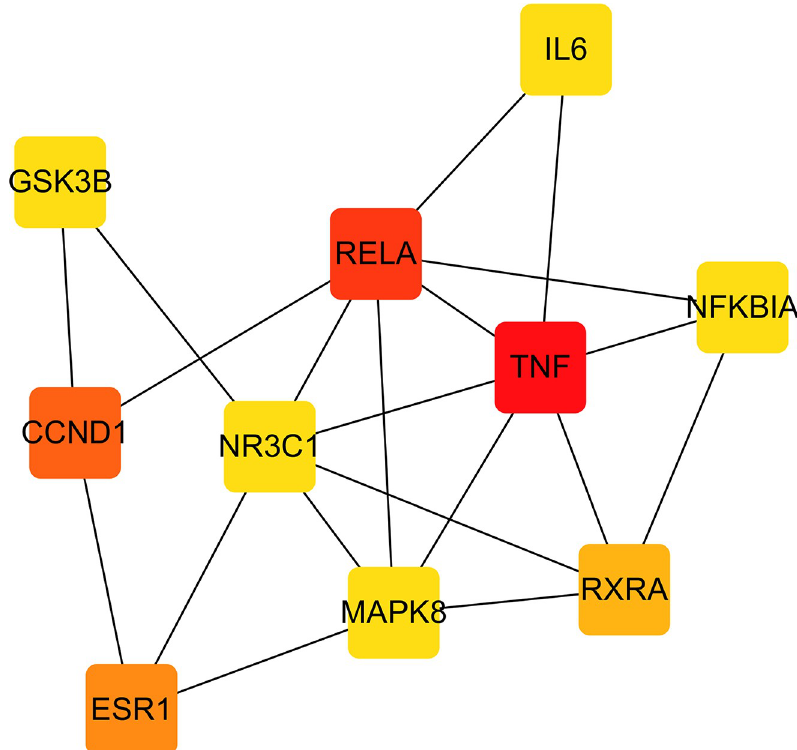
Fig 5. Analysis of the top 10 hub gene networks of YSTLF for oligoasthenozoospermia treatment by the MCC algorithm, in which red and yellow represent the importance in the network.